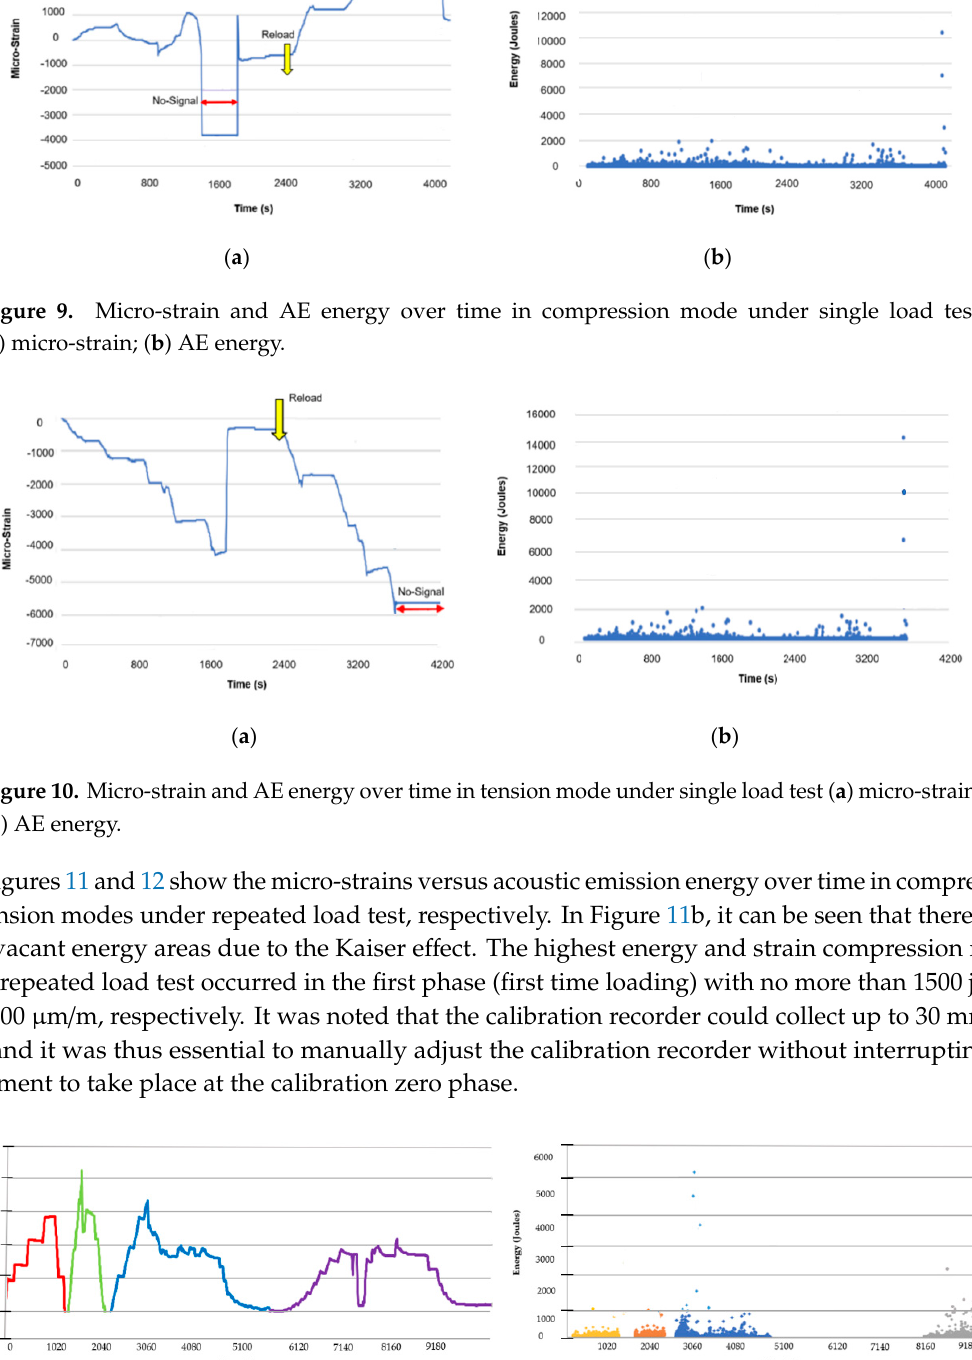
( a ) ( b ) Figure 12. Micro-strain and AE energy over time in tension mode under repeated load test ( a ) micro-strain; ( b ) AE energy.